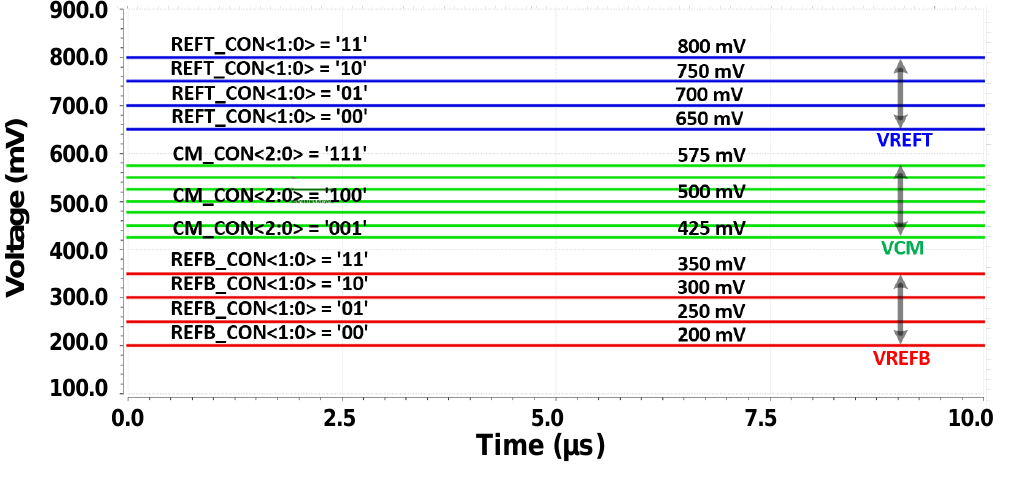
Figure 10. Reference voltage generator simulation result.